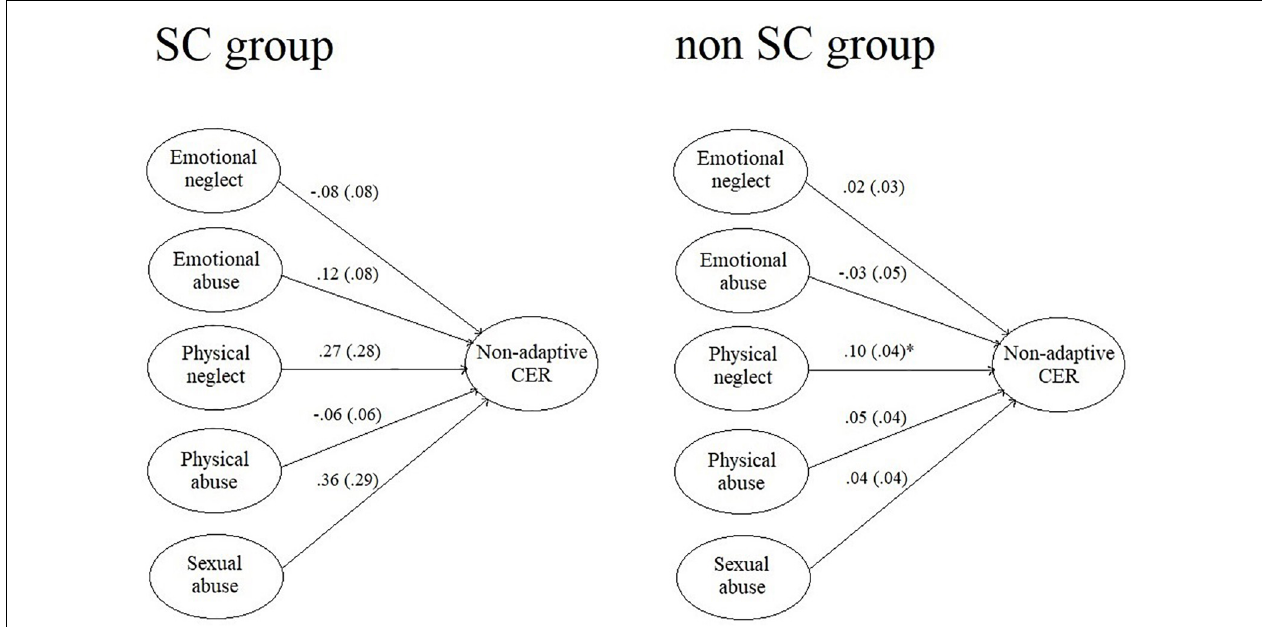
FIGURE 2 | The variability of non-adaptive cognitive emotion regulation strategies explained by childhood traumatic experiences among SC and non-SC-using clients. ∗ p < 0.05; unstandardized B coefficients are presented with standard errors (in brackets). SC, synthetic cannabinoids; CER, cognitive emotion regulation.